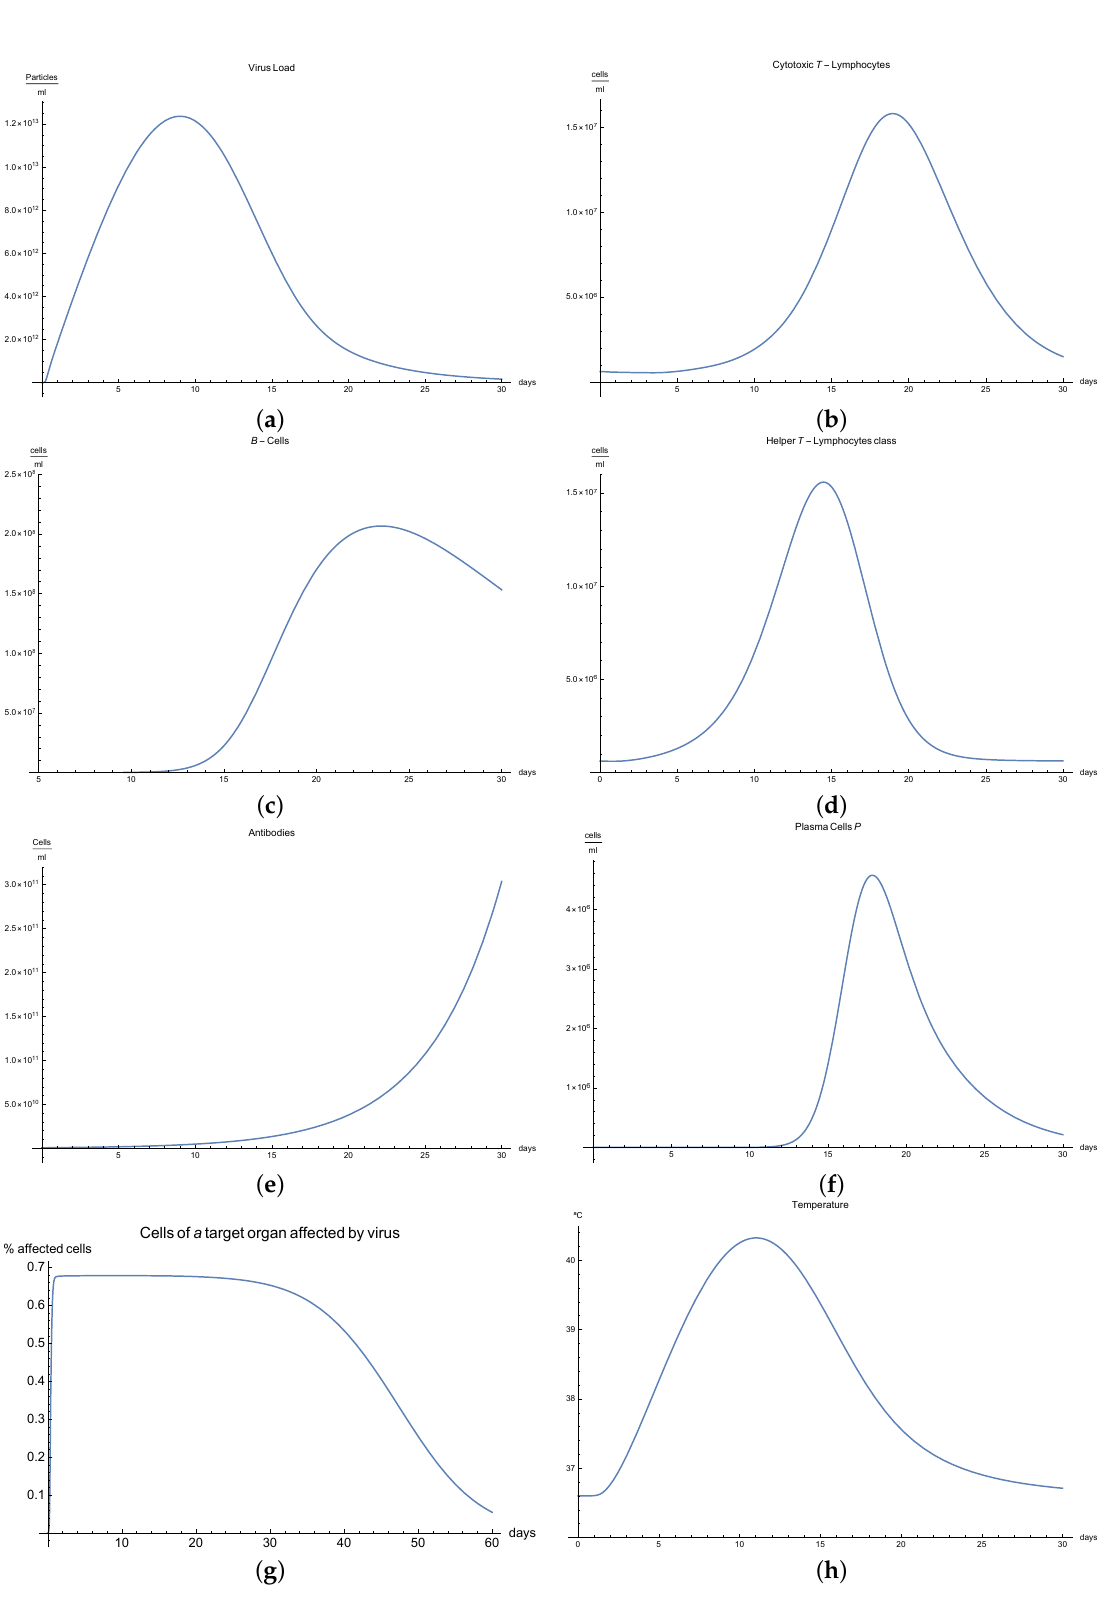
Figure 1. Numerical results of the mathematical model for the case in which the immunophysiological response of COVID-19 infection in its ”normal” form: ( a ) the viral load V ( t ) , ( b ) the cytotoxic T-lymphocytes T e ( t ) , ( c ) the B-lymphocytes B ( t ) , ( d ) the class 1 helper T-lymphocytes T H 1 ( t ) , ( e ) the antibodies A ( t ) , ( f ) the plasma cells P ( t ) , ( g ) the malfunctioning part of a target organ affected by viruses m ( t ) , and ( h ) body temperature θ ( t ) . In all cases, the numerical results are simulated for the “normal